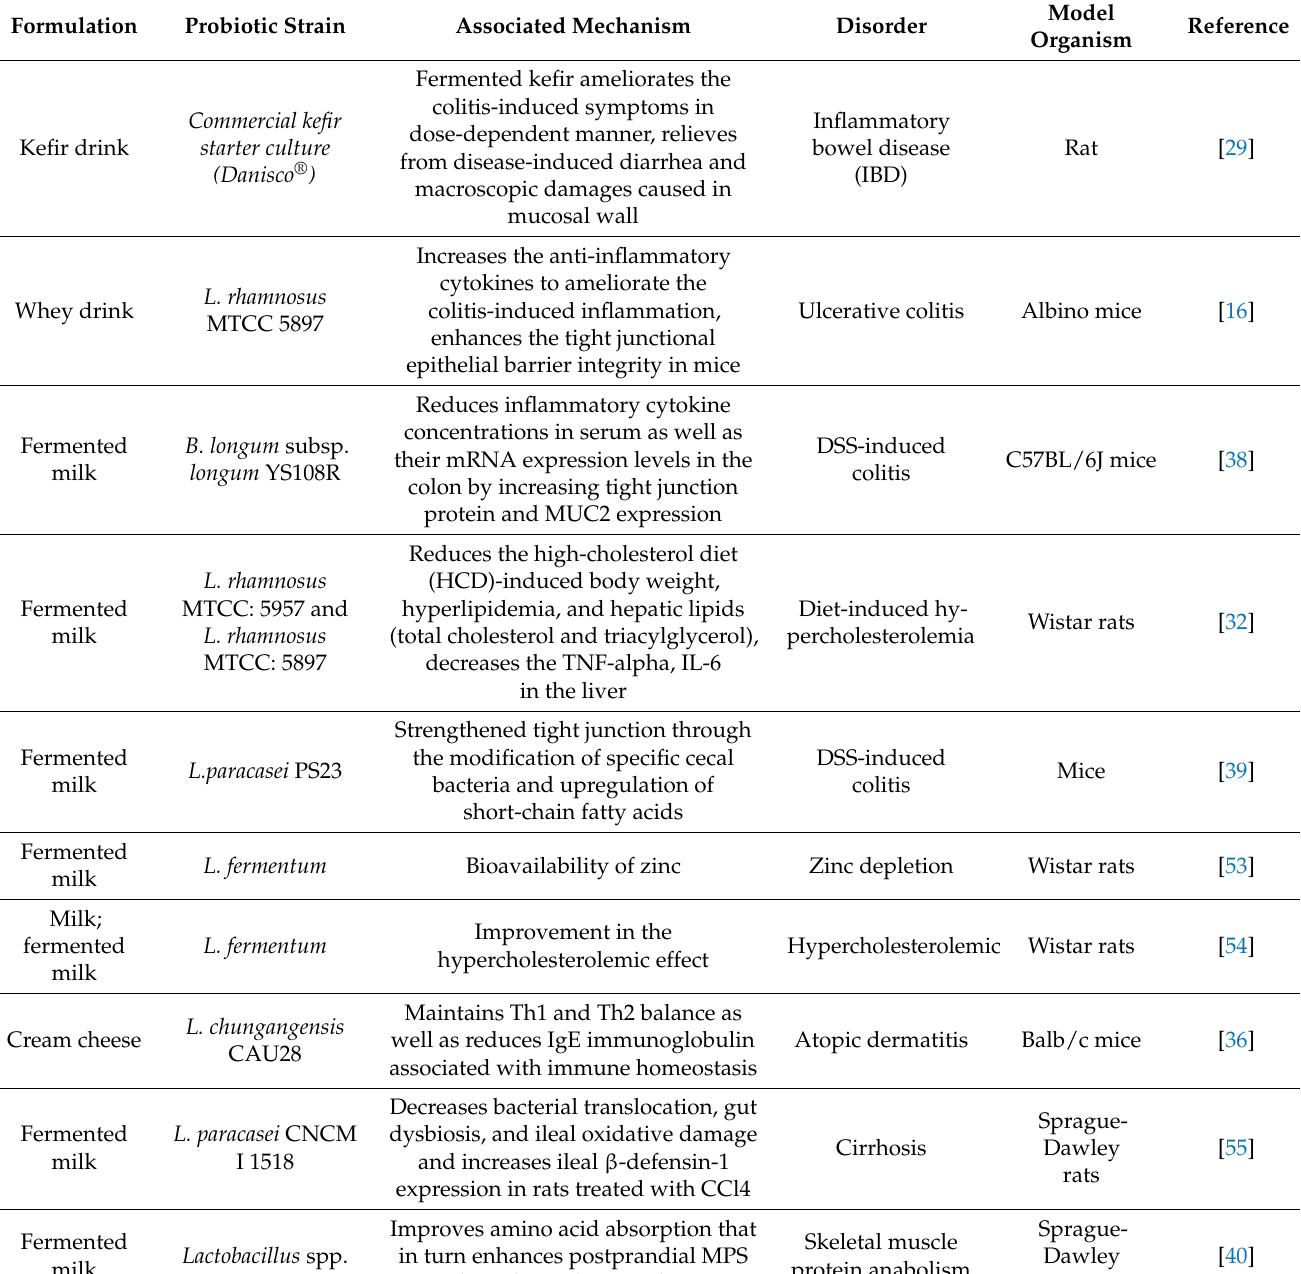
Table 2. The beneficial effects of probiotic-fermented products on human health showing in vivo and in vitro